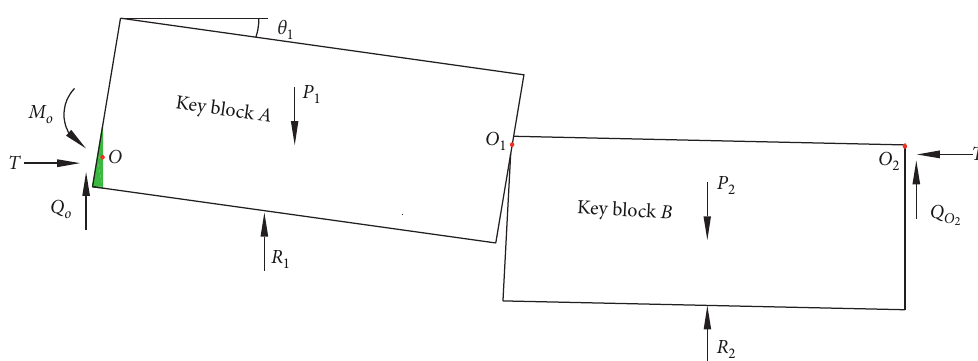
Figure 6: Interaction mechanics model between key blocks A and B ( T ≠